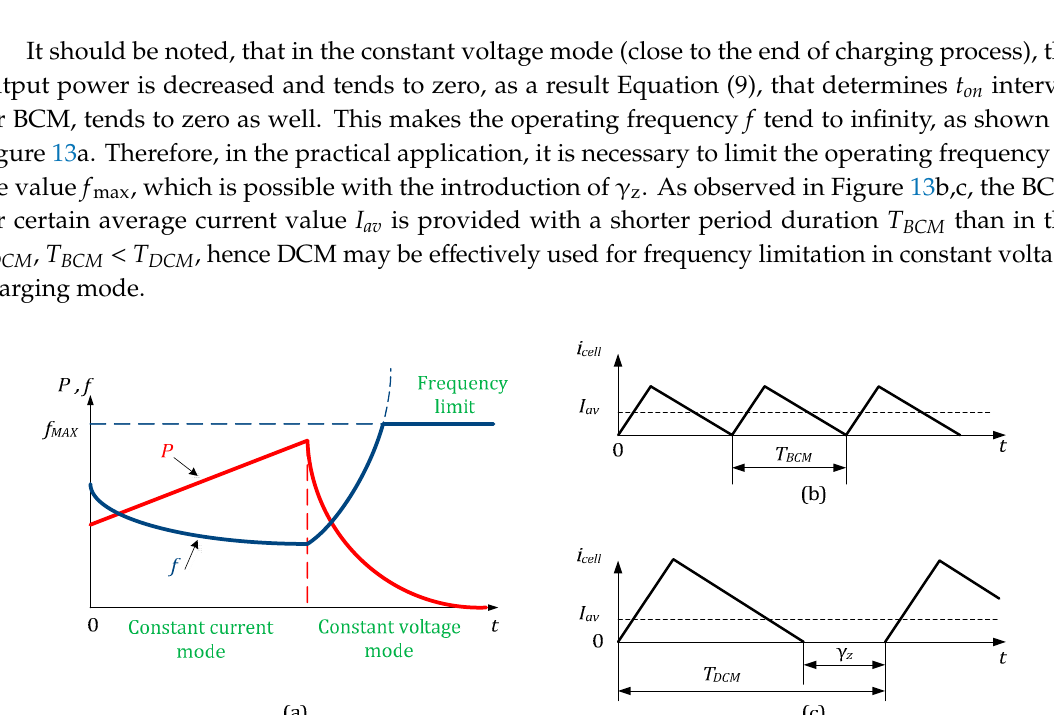
( a ) ( b ) Figure 14. PSIM model: ( a ) SEPIC power circuit; ( b ) corresponding control system. The model of the two-cell converter additionally contained two voltage sources Gen1 and Gen2 that created initial voltages at the cell outputs. The control system consisted of two sawtooth-wave voltage sources S1 and S2, which were connected via AND gate to comparator DA1, allowing the generation of a PWM signal with a smooth increase of duty cycle γ from zero to nominal value. Time delay block “Delay” created a half-period delay for transistor of the second cell. The charging process was stopped when output voltage measured with a resistive sensor exceeded the reference voltage U ref .